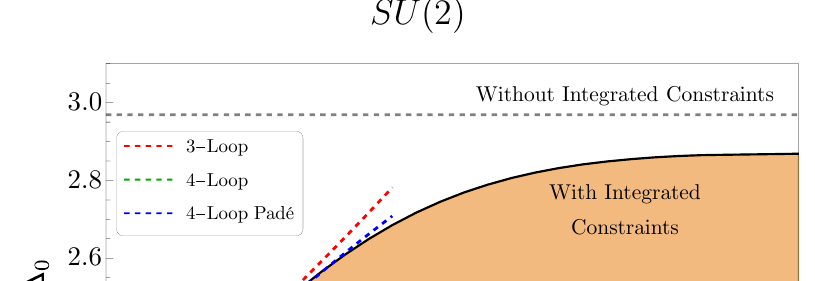
/ 4 π for YM / 4 π from 0 to YM = 4 π YM